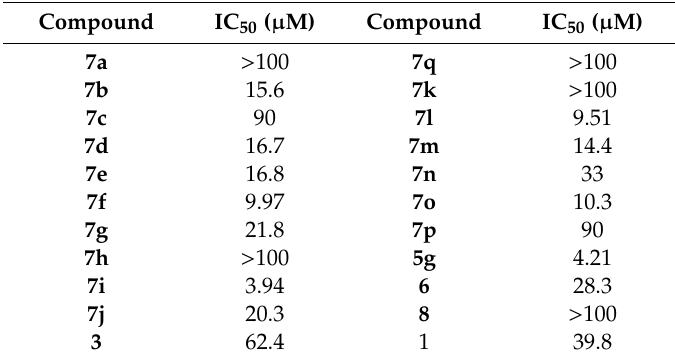
Table 5. Cytotoxicity study of Series III